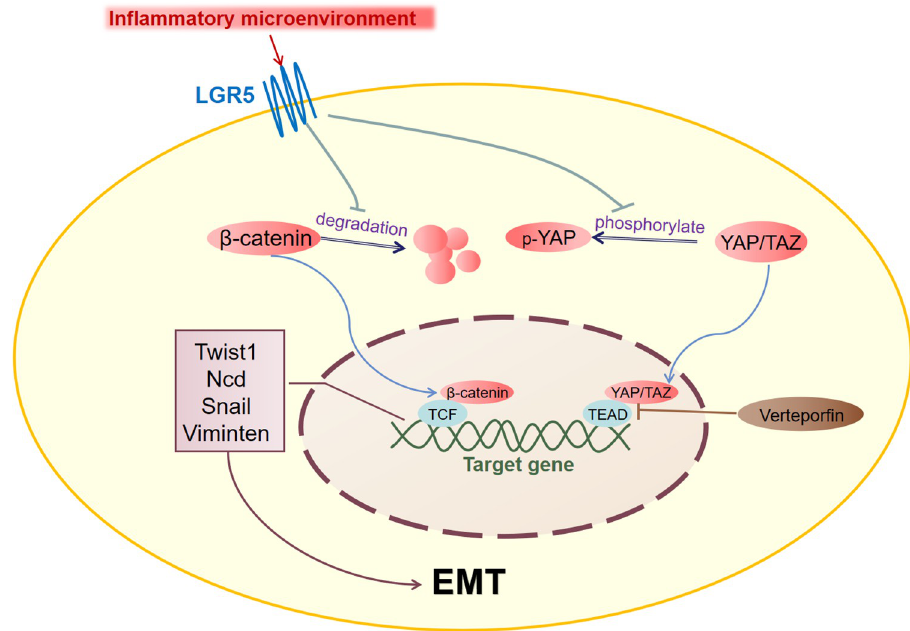
Fig 7. Model for the inflammatory condition results in high expression of LGR5 and tumor cells EMT. LGR5 inhibited β -catenin protein degradation and YAP/TAZ phosphorylation in cytoplasm during hypopharyngeal cancer cells development. Then, β -catenin and YAP/TAZ aggregated in the cytoplasm are introduced into the nucleus and bind to TCF and TEAD family transcription factors, respectively, which together activate transcription of downstream target genes (Twist1, NCD, Snail, Viminten), directly promoting epithelial mesenchymal transformation. Verteprofin (VP) is an effective inhibitor of YAP, which severely interferes with YAP-TEAD interaction.